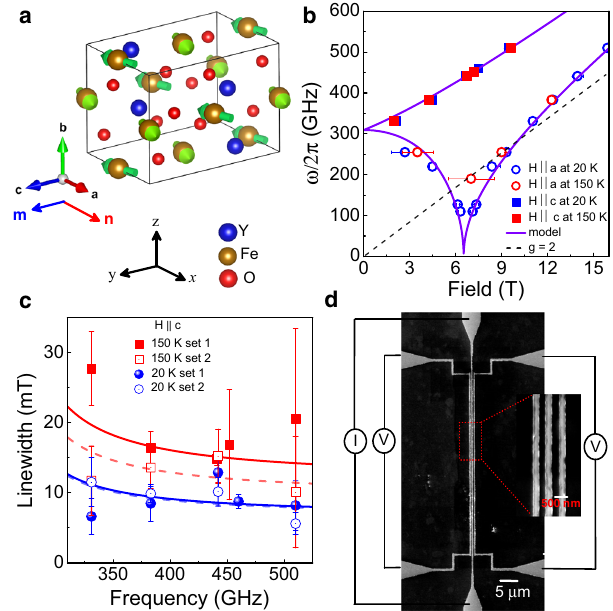
Fig. 1 | Crystal structure, magnetic resonance and the device. a Crystal struc- tures of YFeO 3 [010], where the nearest neighbour Fe-ions are coupled anti- ferromagnetically along the easy-axis ([100] a -axis) and the moments are slightly canted along the c -axis which yield a net weak magnetization directed parallel to the c -axis.The arrowsinthe structureindicate the direction of spins of the Feions. b Resonance frequency as a function of magnetic fi eld along a-axis (open symbol) andc-axis(closedsymbol)fortwodifferenttemperatures,20Kinblueand150Kin red.The modelparametersfor the fi ts are μ 0 H E =635 T , μ 0 H a =0 : 19 T , μ 0 H b =0 : 7 T and μ 0 H DMI =12 T . The g =2 line shows the frequency of a potential spurious paramagnetic resonance. c Linewidth as a function of frequency for the con fi g- uration of H along c-axis at 20K and 150K. The open and closed symbols corre- spond to data taken separately, afterremovaland reintroduction of the sample,to testreproducibility.Thesolidsolidanddashedlinesarethetheoretical fi ttingusing the model from Fink 42 , which yields damping coef fi cients of 3.5±0.4×10 − 6 and 3.4±0.3×10 − 6 forthetwosetsofdataat20Kand6.2±0.3×10 − 6 and4.6±0.5×10 − 6 for 150K. The extracted parameters from ( b ), μ 0 H E , μ 0 H a , μ 0 H b and μ 0 H DMI are used in this model. d SEM image of a typical device, where the charge current is drivenalongthemiddlewireandthenon-localvoltagesaremeasuredinbothwires to the left and right of it. We associate orthogonal coordinates with the crystal- lographic axes: x ǁ a , y ǁ c , z ǁ b